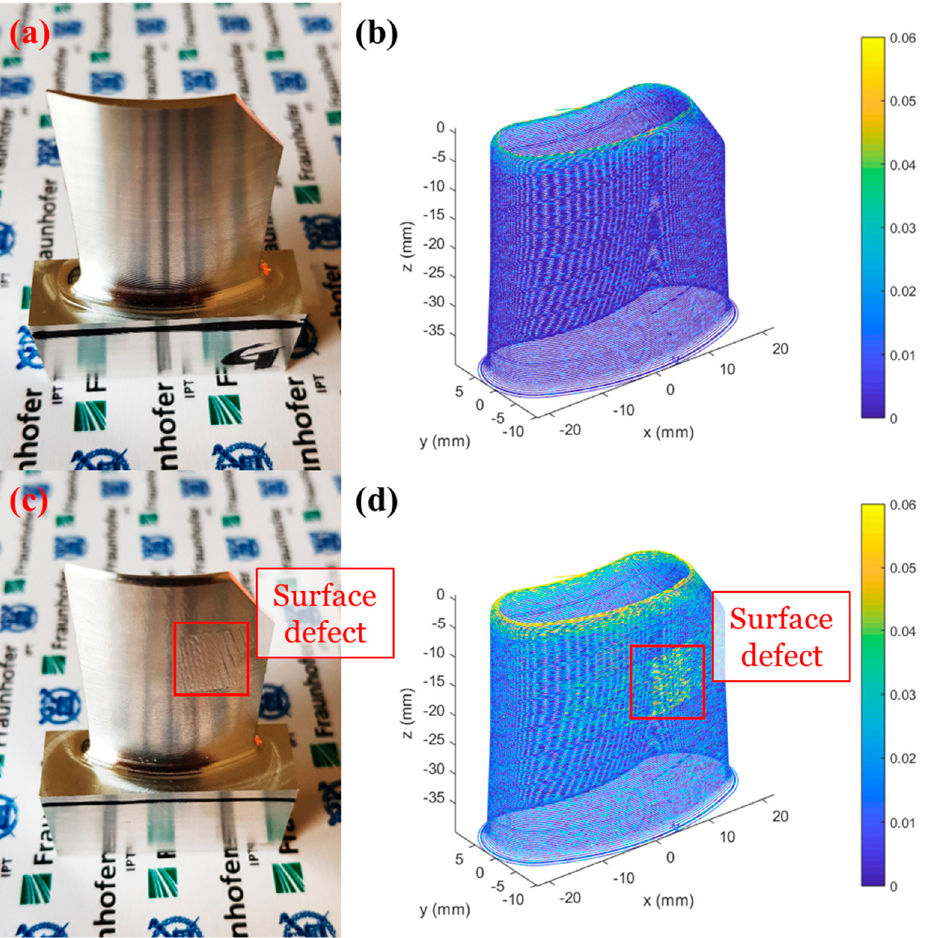
Figure 10. ( a , c ) The photograph of turbine blades with good and poor surface quality. ( b , d ) A real-time quality prediction based on vibration data measured by a directly printed sensor with good and bad surface quality.